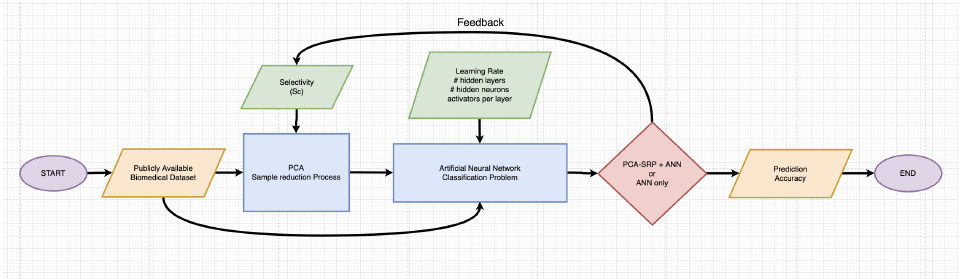
Figure 6. Conceptual flowchart of the proposed approach.